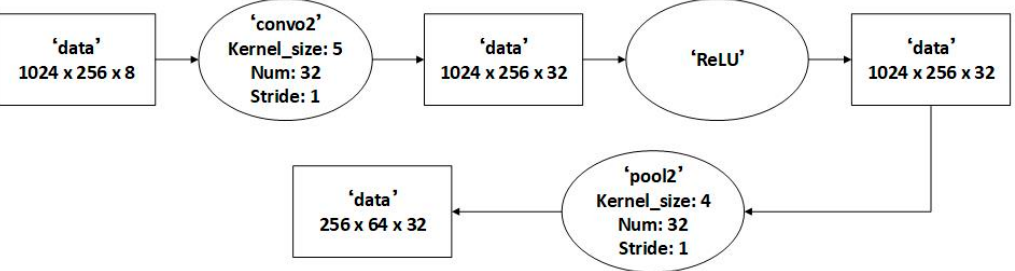
Figure 6. Convo2 convolutional layer process.